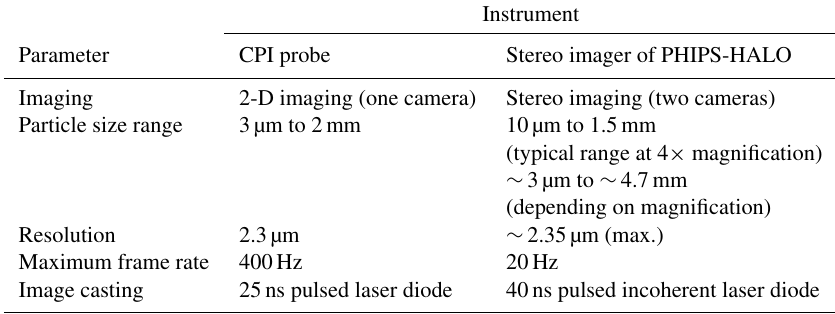
Table 2. Specifications of the stereo-imager component of PHIPS-HALO compared to those of the CPI